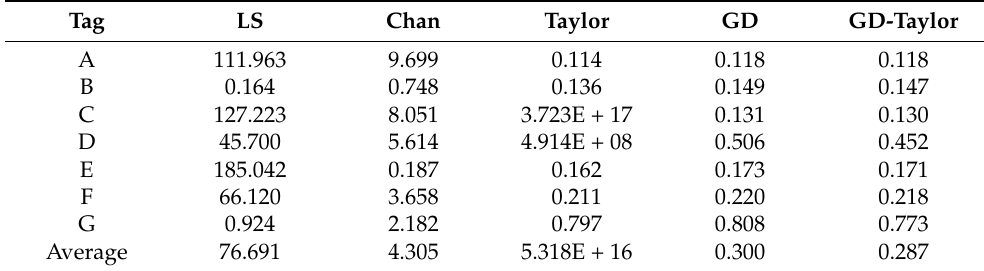
Figure 5. The deployment of anchors and tags in simulation and measurement of the UWB posi- tioning system with the TDOA algorithm. The black circles represent the real positions of tags, and the red triangles represent the positions of Anchors, including the Center. Table 2. RMSEs of Tag positions using different algorithms in simulation. Table 2. RMSEs of Tag positions using different algorithms in simulation.